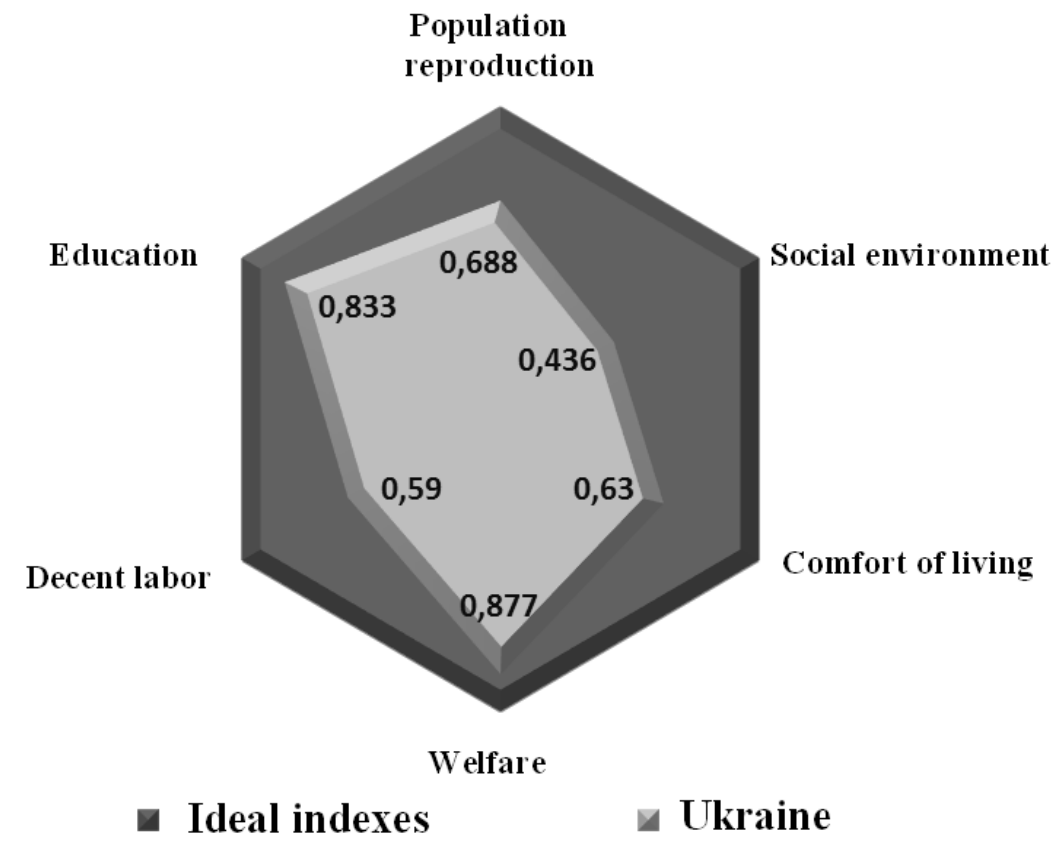
Fig. 3. The lagging from the target parameters for certain aspects of the regional human development Source: figure is developed based on the methods of calculating a regional human development index